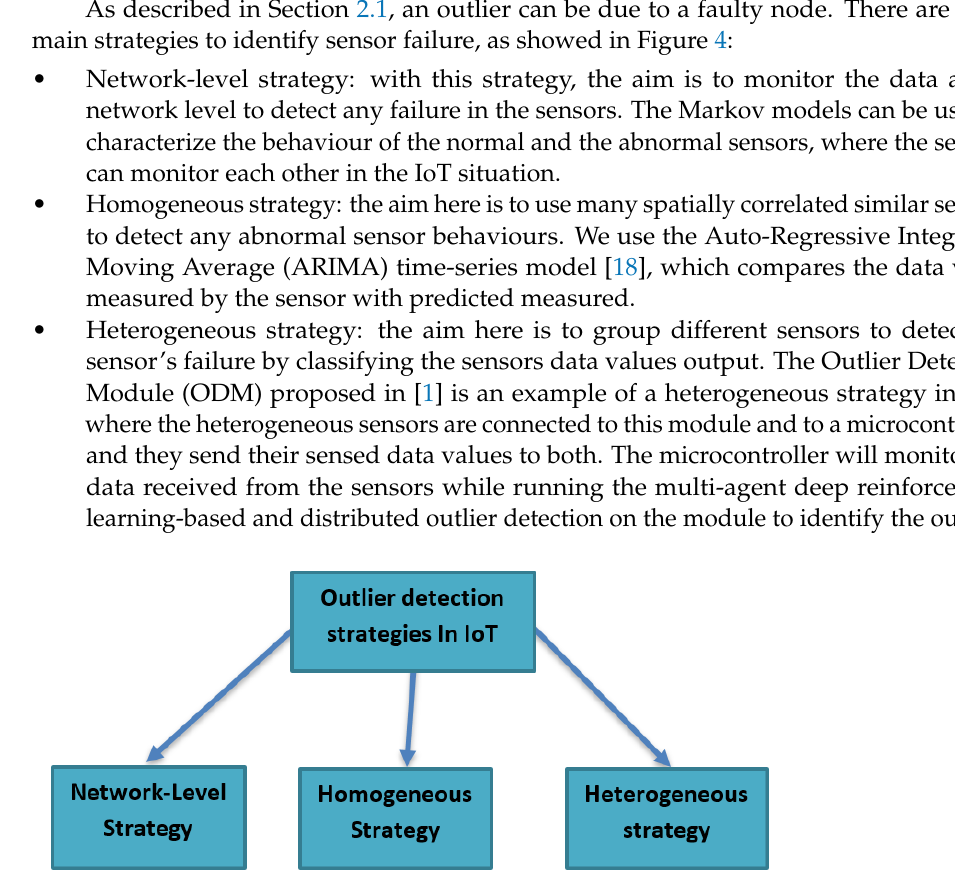
Figure 4. Outlier detection strategies in